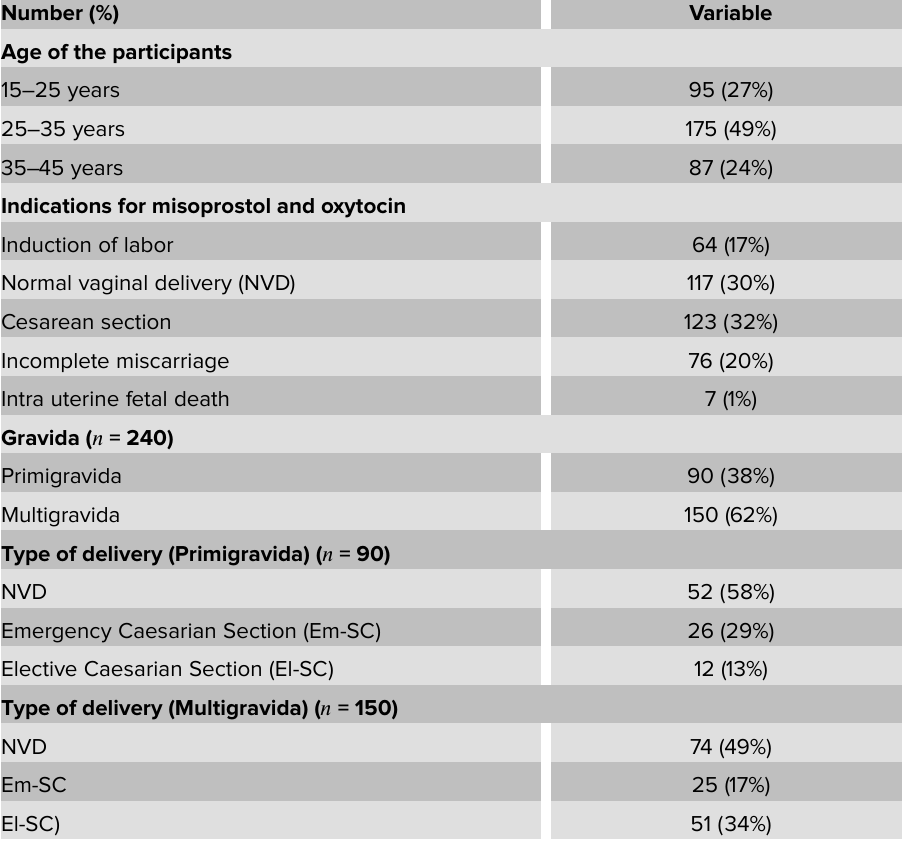
TABLE 1: Socio-demographic and clinical characteristics of the participants ( n =